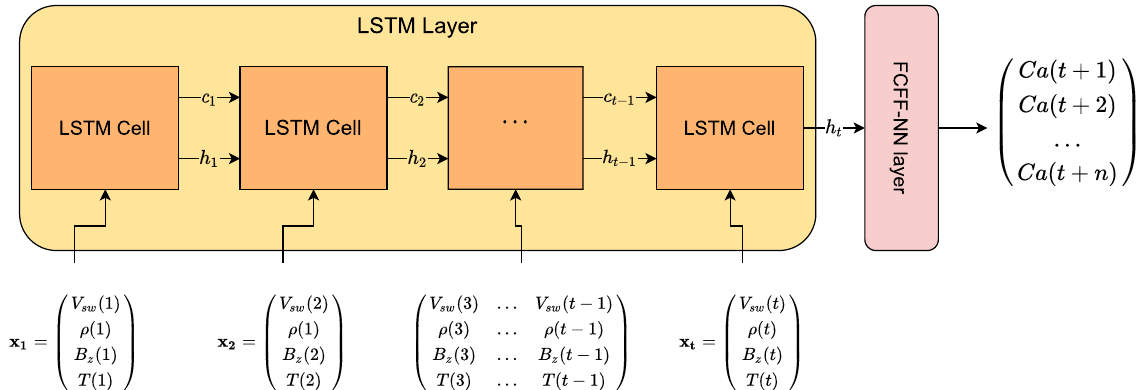
Fig. 3. Simple scheme representing the LSTM-based model to forecast the values of the Ca index up to n hours in advance. The mechanism inside the LSTM cell was voluntarily